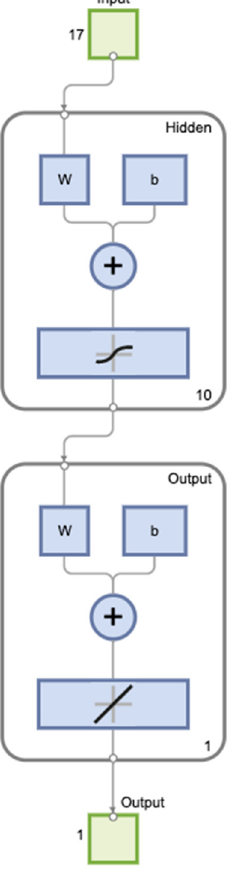
Figure 1. Graphic representation of the FFBPN model.